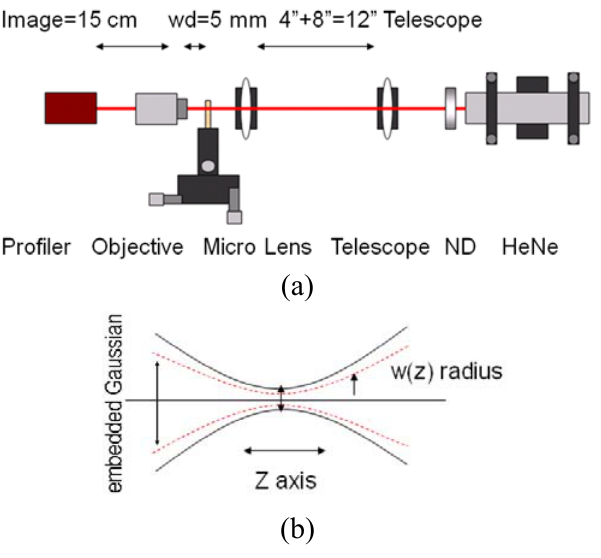
Figure 4. (a) Schematic of beam profiling with a CCD camera. (b) Focusing of Gaussian beam (dotted line) and non-Gaussian beam (solid